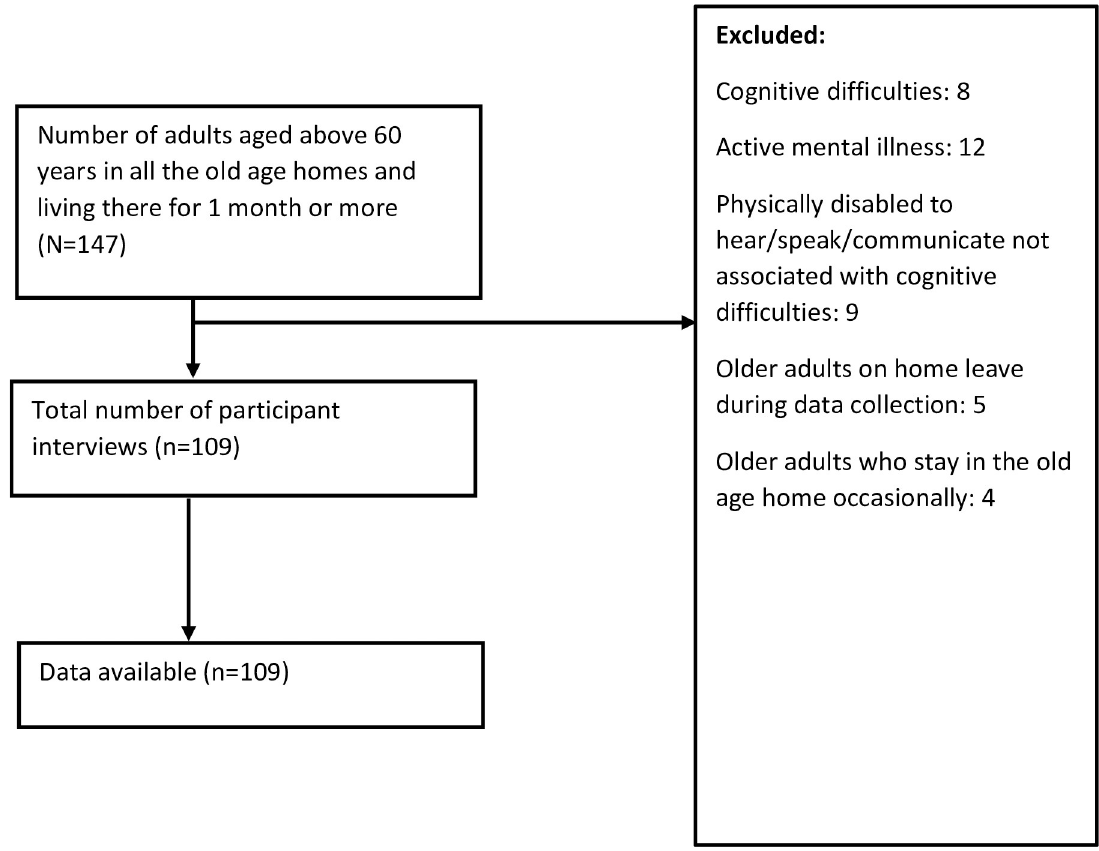
Fig 1. Selection of participants for the